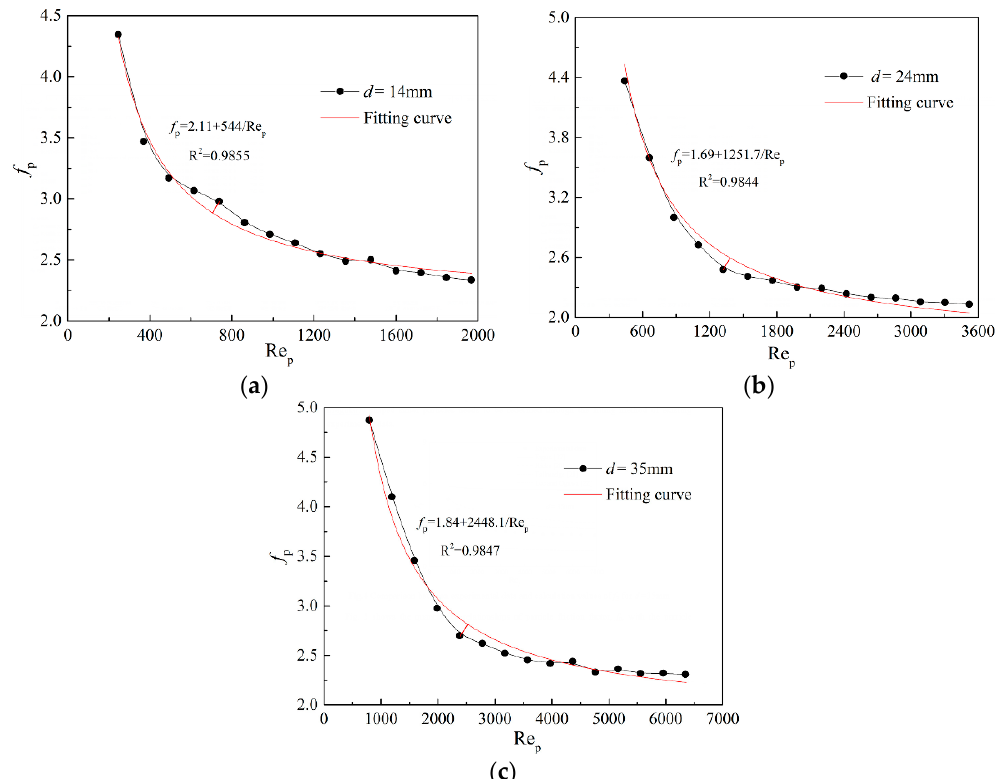
Figure 3. Relationships of the particle friction factor with the particle Reynolds number for different particle diameters. ( a ) d = 14 mm; ( b ) d = 24 mm; ( c ) d = 35 mm.